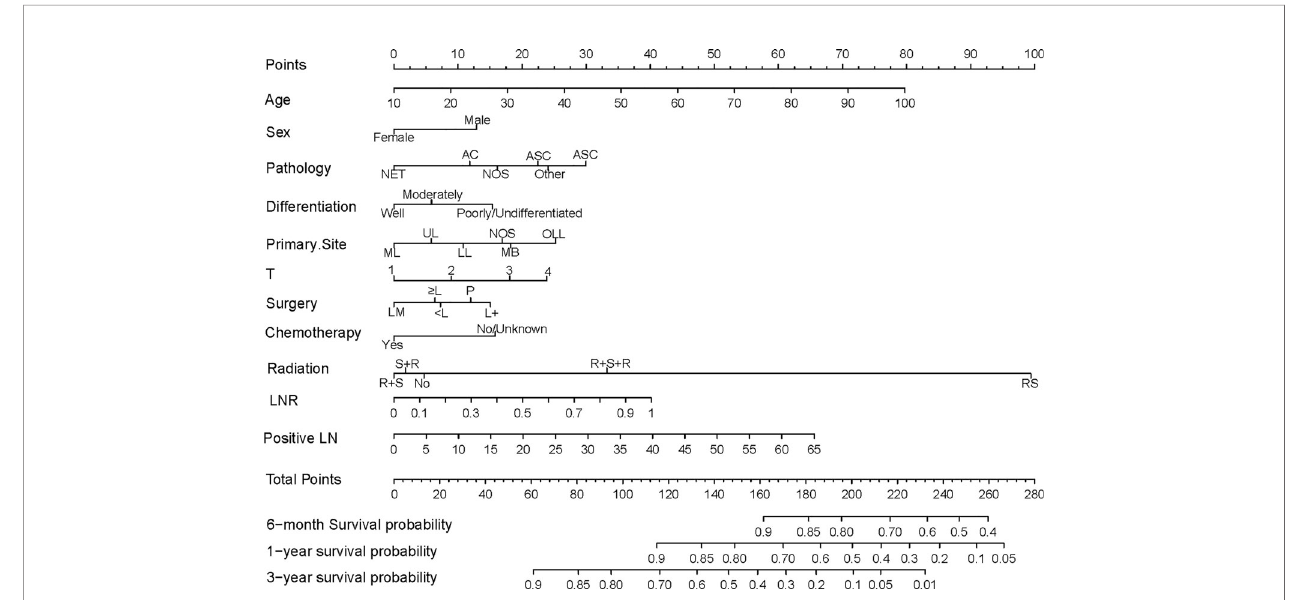
FIGURE 2 | Nomogram predicting postoperative survival of pN2 NSCLC patients who underwent surgery. The value for each factor was located and a straight line was drawn upwards to the “ points axis ” of the nomogram to determine the number of points for the factor. The total number of points was calculated by summing the points for all factors. The value for each factor was found on the “ total points axis ” and a line was drawn straight downwards to the “ survival axis ” to estimate the probabilities of OS at 0.5, 1, and 3 years. AC, Adenocarcinoma; NET, Neuroendocrine tumor; SCC, Squamous cell carcinoma; ASC, Adenosquamous carcinoma; NOS, Not otherwise speci fi ed; ML, Middle lobe; UL, Upper lobe; LL, Lower lobe; MB, Main bronchus; OLL, Overlapping lung lesion; LM, Lobectomy with medial lymph node dissection; ≥ L, Resection of [at least one] lobe or bilobectomy; <L, Excision or resection of less than one lobe; P, Pneumonectomy; L+, Lobe or bilobectomy extended; R+S, Radiation prior to surgery; RS, Intraoperative radiation with other radiation before/after surgery; R+S, Radiation prior to surgery; S+R, Radiation after surgery; R+S+R, Radiation before and after surgery; LN, lymph node